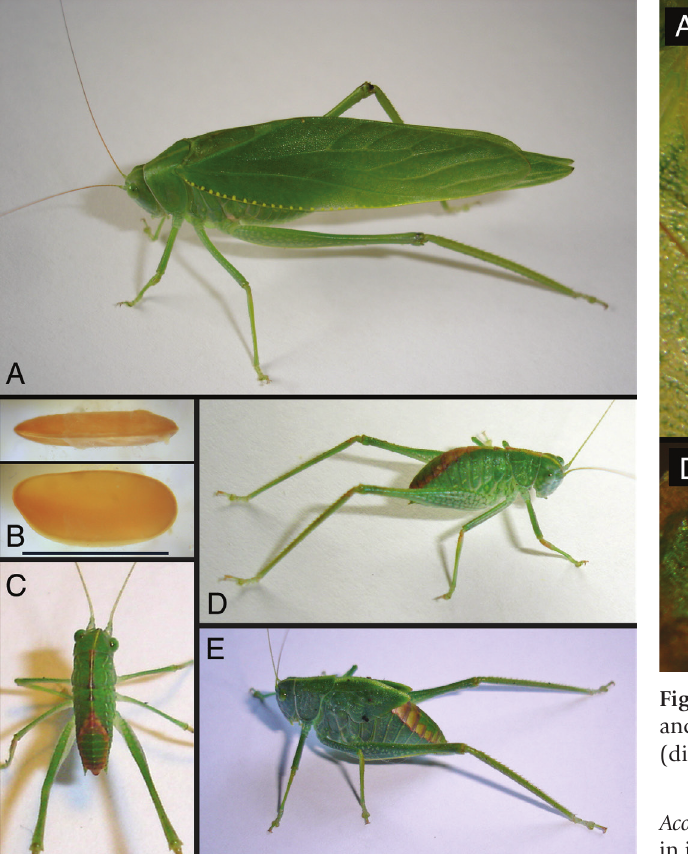
Fig. 1. Habitus. A. Adult male; B. Egg (lateral and ventral view, scale 5 mm); C. Nymph, 3 rd March; D. Nymph, 30 th March; E. Fe- male nymph, 10 th May, 10 days before imaginal molt.